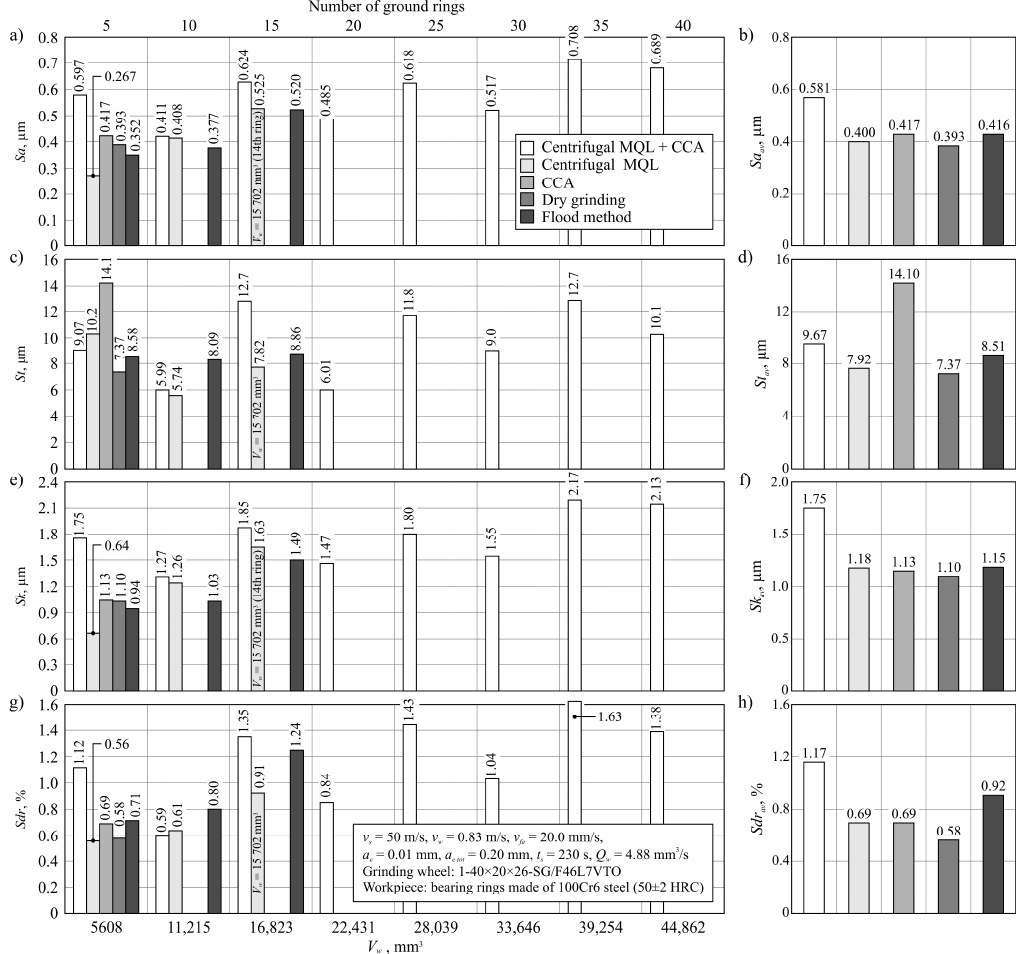
Figure 7. Parameters of the workpiece surface texture ( a , c , e , g ) as well as the average values ( b , d , f , h ) measured after grinding using different conditions of cooling and lubrication: ( a ) arithmetic mean deviation of the surface Sa ; ( b ) average arithmetic mean deviation of the surface Sa av ; ( c ) total height of the surface St ; ( d ) average total height of the surface St av ; ( e ) roughness depth of the core Sk ; ( f ) average roughness depth of the core Sk av ; ( g ) developed interfacial area ratio Sdr ; ( h ) average developed interfacial area ratio Sdr av.